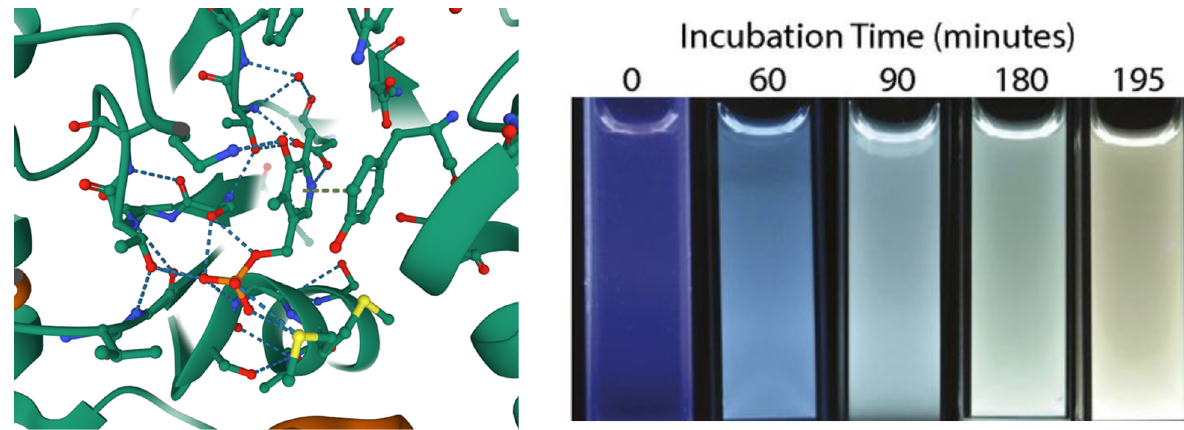
Figure 7. ( On the left ) . A zoom into the cystathionine gamma-lyase structure (from PDB entry 6k1n) reveals the interactions between the PLP cofactor and active site amino acids. Tyr 110 interacts with the aromatic group of the PLP cofactor contributing to its orientation for enzyme catalysis. ( On the right ). Photographs of photoluminescence under UV light at various time intervals. The redshift of the fluorescence indicates an increase with incubation time in the size of the CdS nanocrystals. Reprinted with permission from Ref. [115].